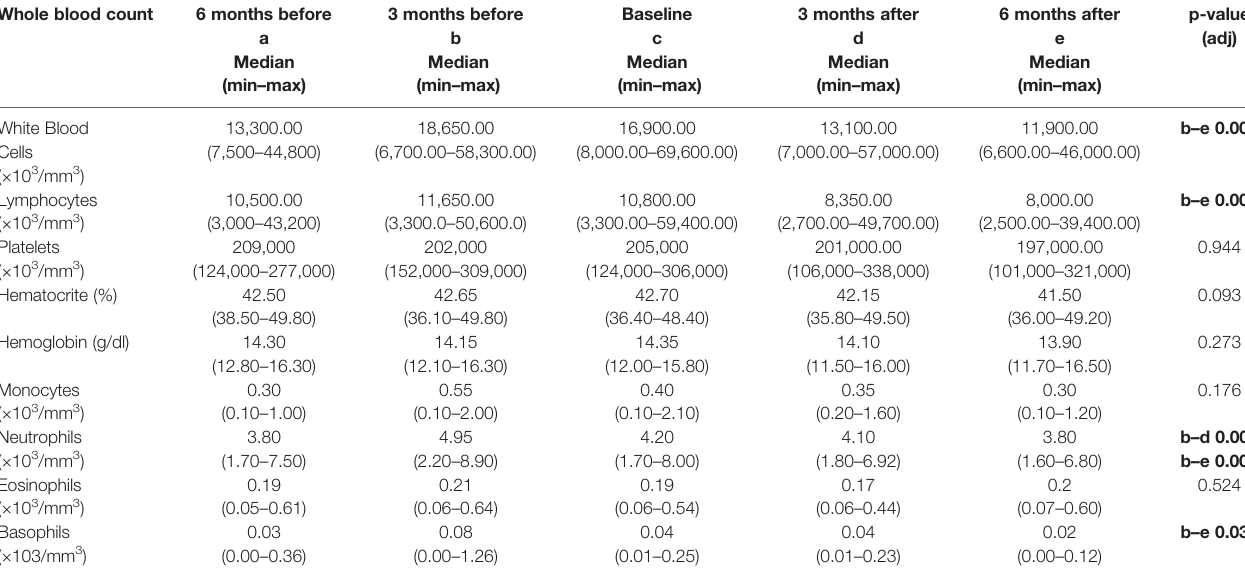
TABLE 2 | Differences in hematological markers of patients with CLL (N = 22) before and during the DI2 with High OC/OL - EVOO. a